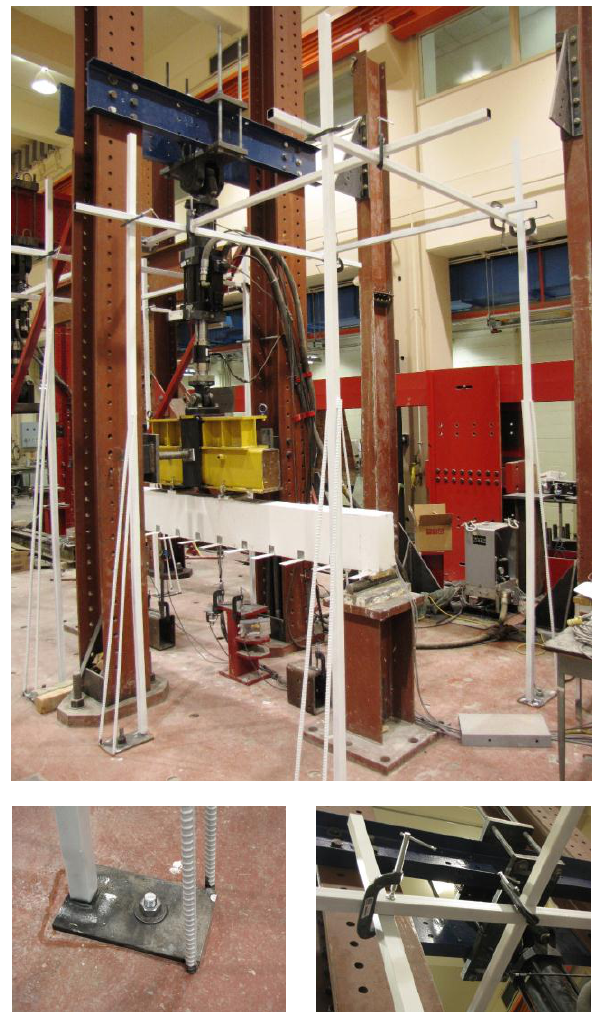
Figure 3. Part of the metal frame built to hoist the cameras and projectors of the digital photogrammetric system